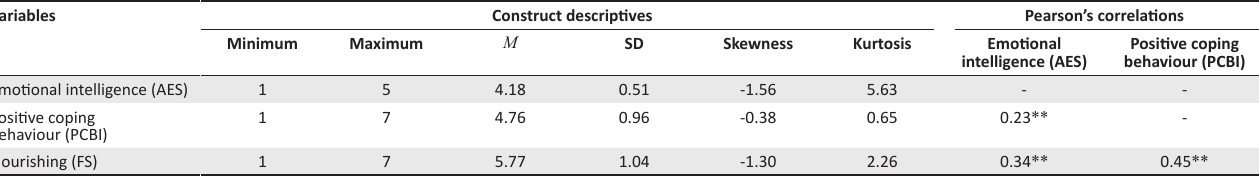
TABLE 4: Descriptive statistics and bivariate correlations. Variables Construct